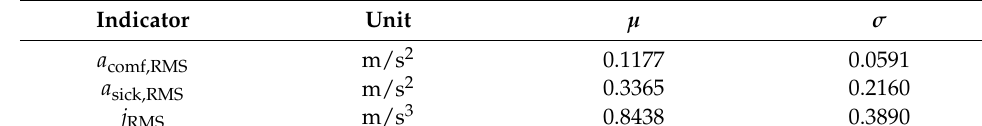
Table 1. Parameters for normal distribution of comfort indicators.